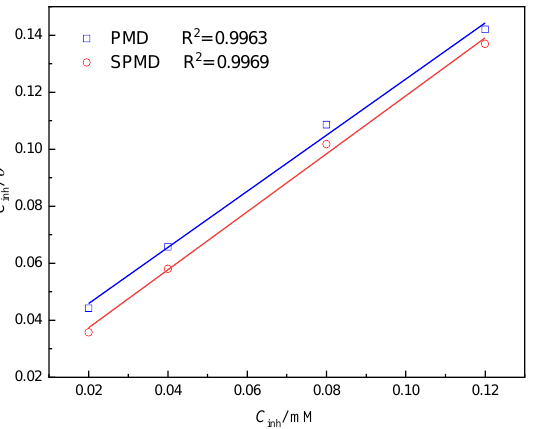
Figure 5. Curve fitting of corrosion data for reinforced steel in SCP solution with different concentrations of perimidine derivatives to Langmuir adsorption isotherm at 25 °C.